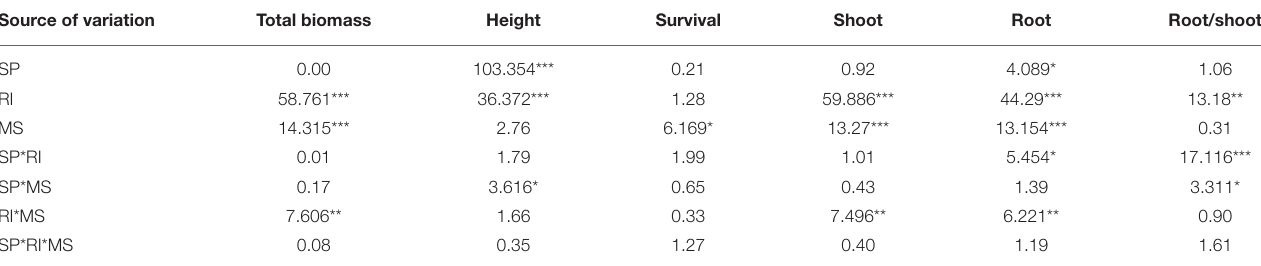
TABLE 1 | Results ( F -values) of three-way ANOVA on the effects of species (SP), root isolation (RI), management strategy (MS: control, N addition, mowing), and their interactions on total biomass, height, survival, shoot and root biomass, and root/shoot. Source of variation